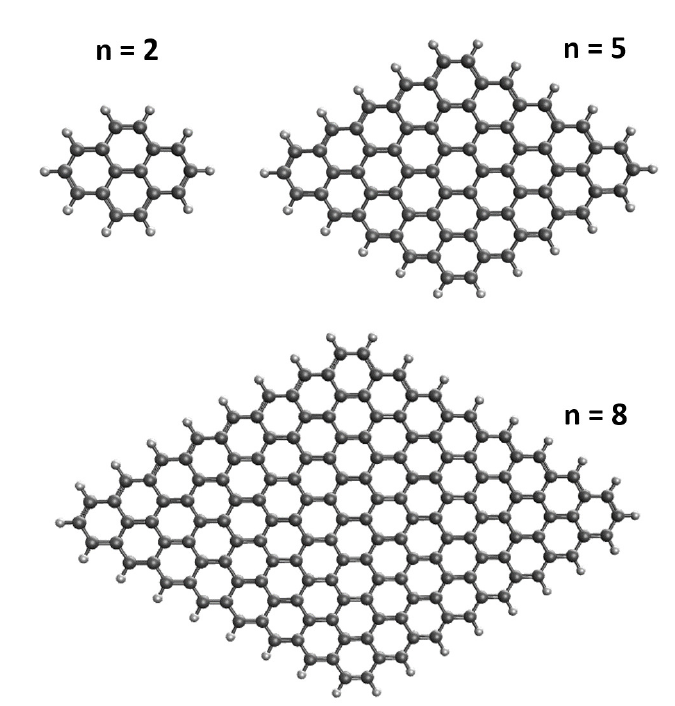
Figure 1. Structure of n -pyrene, which contains n benzenoid rings fused together at each